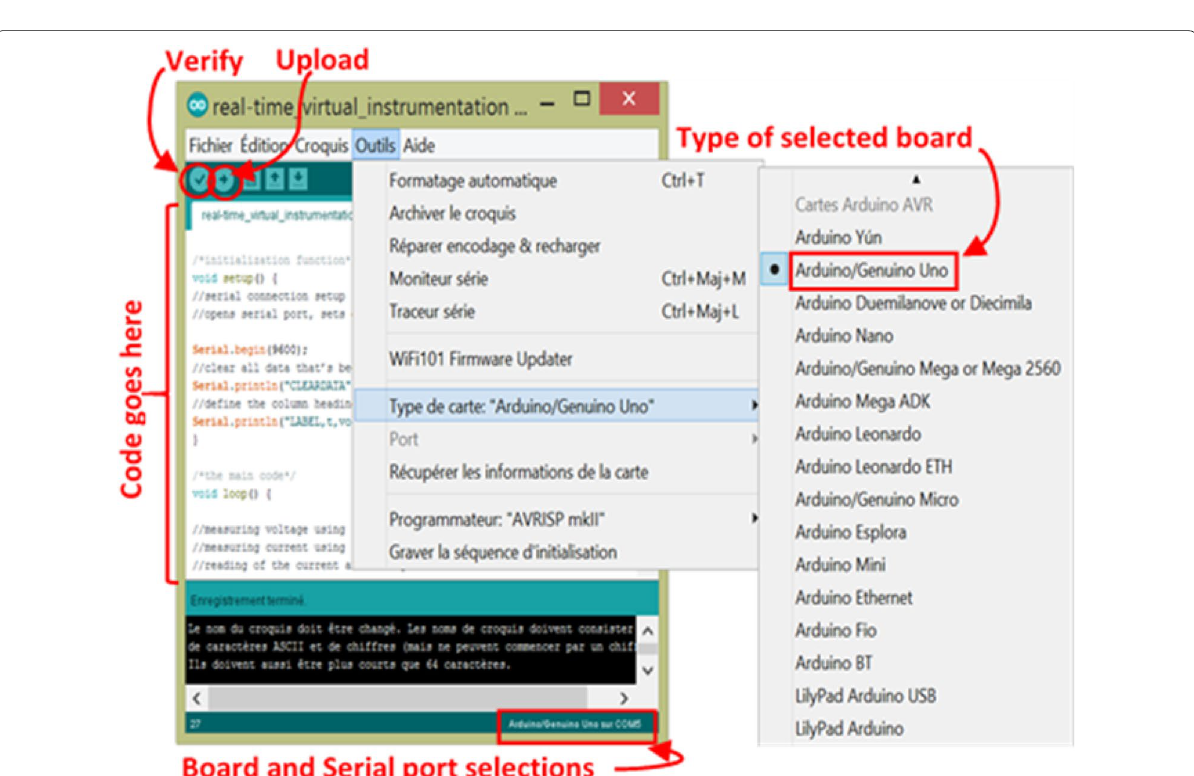
Fig. 11 IDE Software